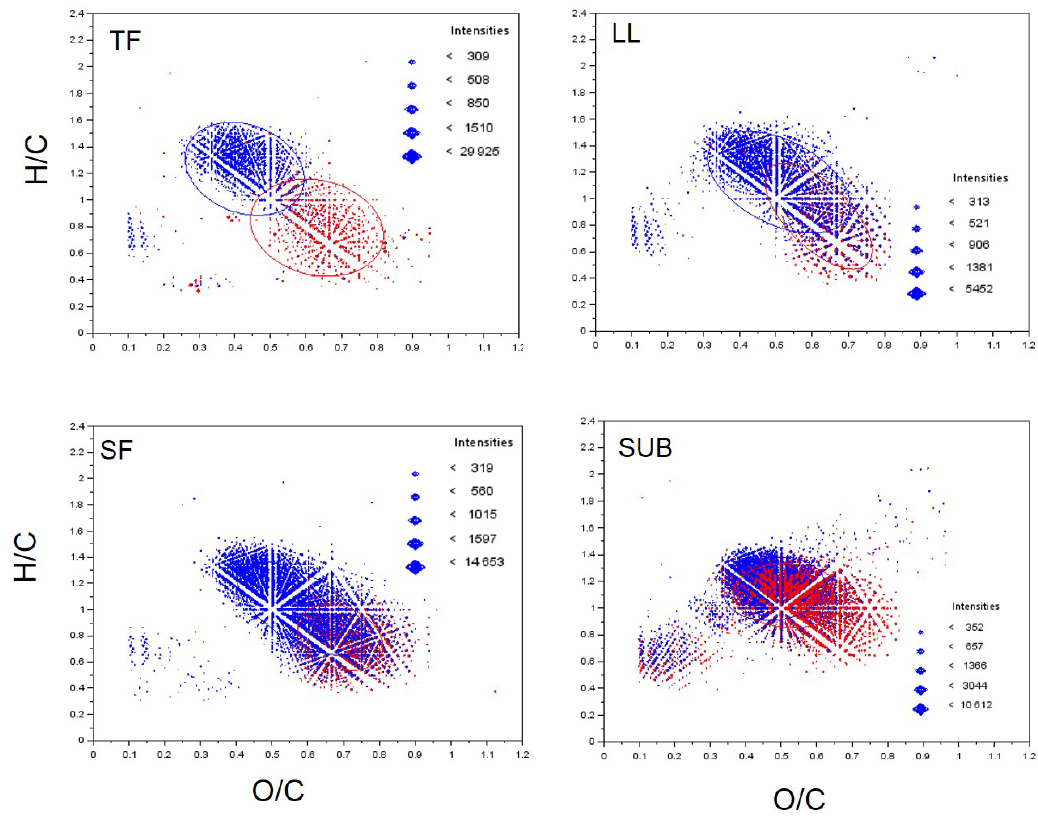
Figure 5. Van Krevelen plots of CHO compounds for unmanaged beech (red) and coniferous (pine, blue) forest DOM samples. Ellipsoids indicate space covered by DOM samples. TF: throughfall; SF: stemflow; LL: litter leachate; SUB: subsoil solution.